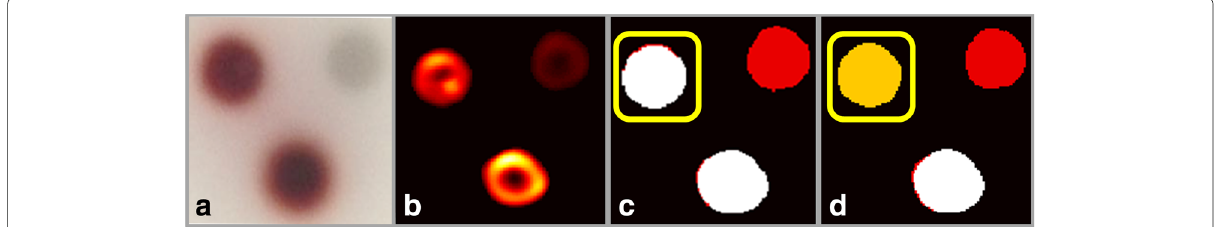
Fig. 8 Blood and ink phantom results. a Imaged region of the experimental phantom. b Photoacoustic tomography imaging after thresholding for the experimental phantom at 730 nm. c Resulting spatio-spectral mean-shift map with no discrimination between dilutions. d Resulting spatio-spectral mean-shift map with discrimination between dilutions. The upper-left inclusion is clustered with the bottom one if there is no dilution discrimination or it remains separate if there is dilution discrimination